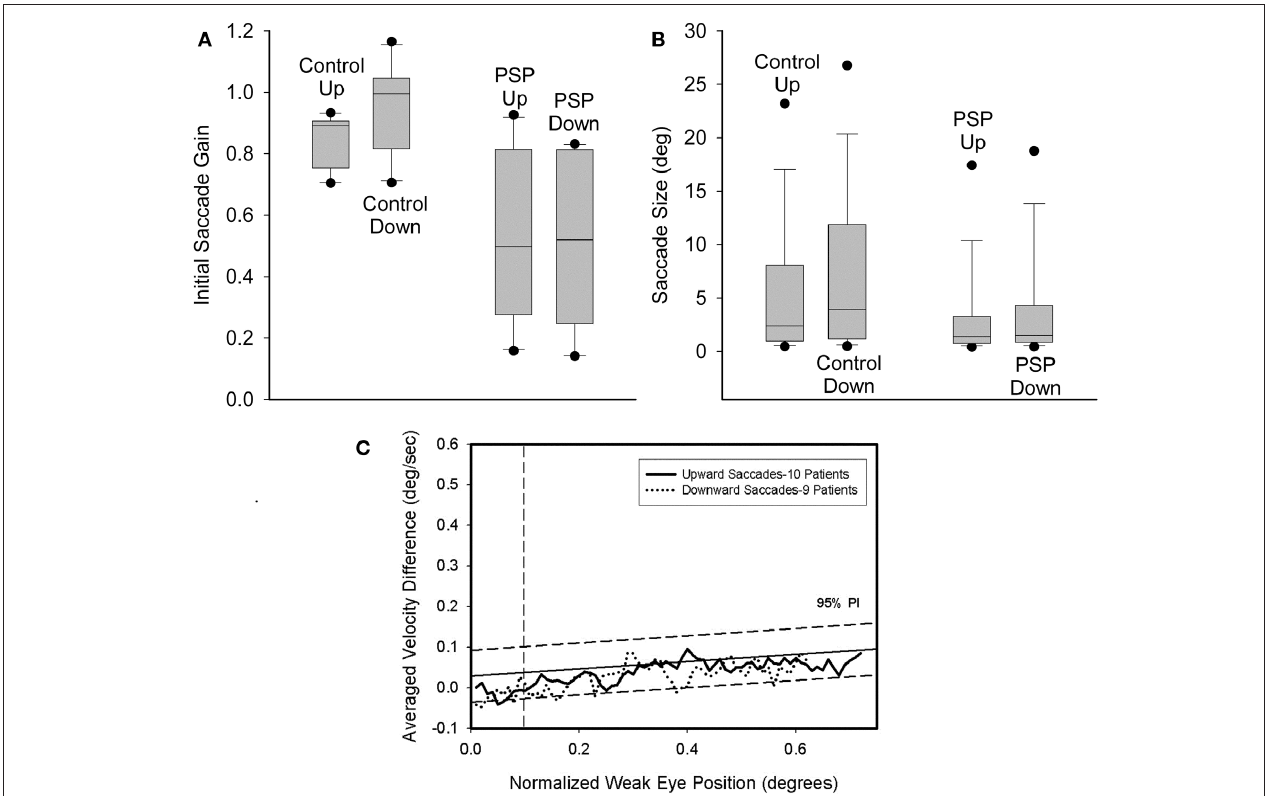
Figure 4 | Comparison of size of vertical saccades made by controls and PSP patients. (A) Gain comparison. Downward gain was larger than upward gain for our 10 control subjects ( p = 0.006), but there was no difference for the 10 PSP patients tested. (B) Amplitude comparison. Downward saccade size was larger than the upward saccade size for both the elderly control ( p < 0.001) and PSP patient ( p = 0.002) groups. Box-plot symbols are similar to Figure 3 ; dot symbols represent 5 and 95% percentiles. (C) Conjugacy of